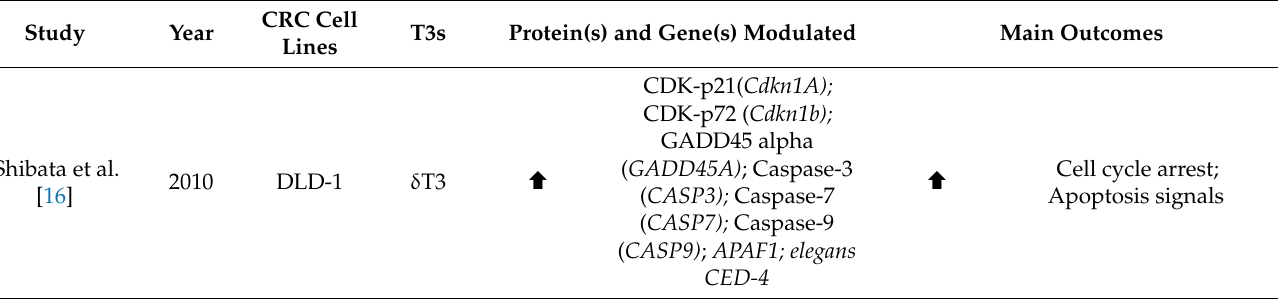
Table 2. Summary of clinically relevant genes and proteins modulated by tocotrienols in human colon cancer cell lines. Table 1. Data extracted from the 12 cell-based research studies. Pathways Involved